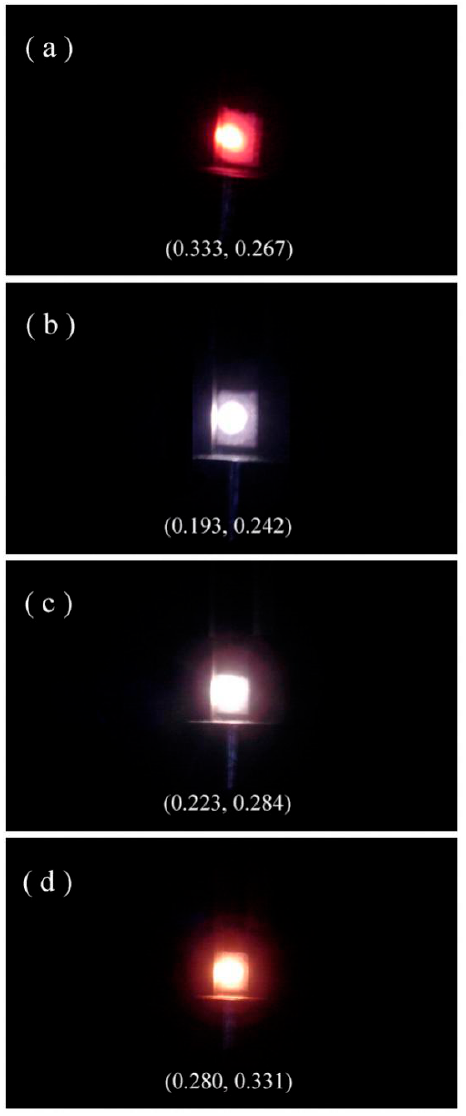
Figure 10. Luminescence photos of Eu-doped ZnWO 4 precursors subjected to annealing at different temperatures: ( a ) 400 °C ; ( b ) 600 °C ; ( c ) 800 °C ; and ( d ) 1000 °C .